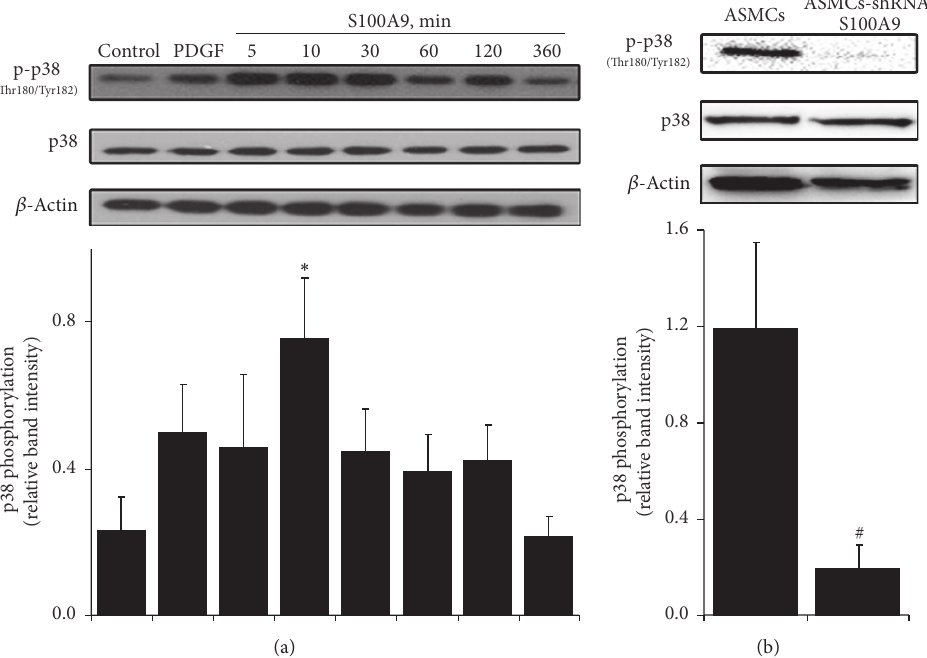
Figure 4: Western blot analysis of the effects of extracellular and intracellular S100A9 on p38 MAPK. (a) Effect of the addition of S100A9 on p38 MAPK in control airway smooth muscle cells (ASMCs). ∗ indicates a significant difference as compared to control ( 𝑃 < 0.05 ). (b) Effect of stable knockdown of S100A9 expression in ASMCs (ASMC-shRNA-S100A9) on p38 MAPK. # indicates a significant difference as compared to